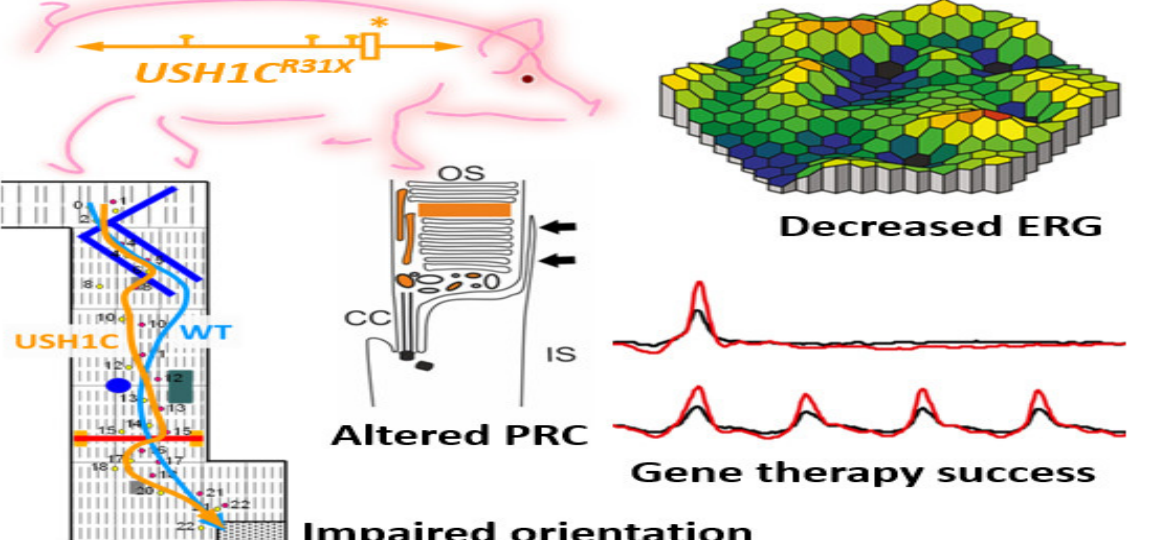
Figure 4. Schematic representation of disruption of photoreceptors architecture to rectify usher syndrome through CRISPR/Cas9 to restore the vision in pig. * Denotes the R31X disruptive mutation at USH gene in the pig model. ERG recordings in USH1C mutant pigs vs. WT demonstrate a significant reduction in the scotopic standard flash responses, dark is dim light and red with bright light stimulus. Matrix plot denotes the impaired orientation of mutant and wild type pigs [84].